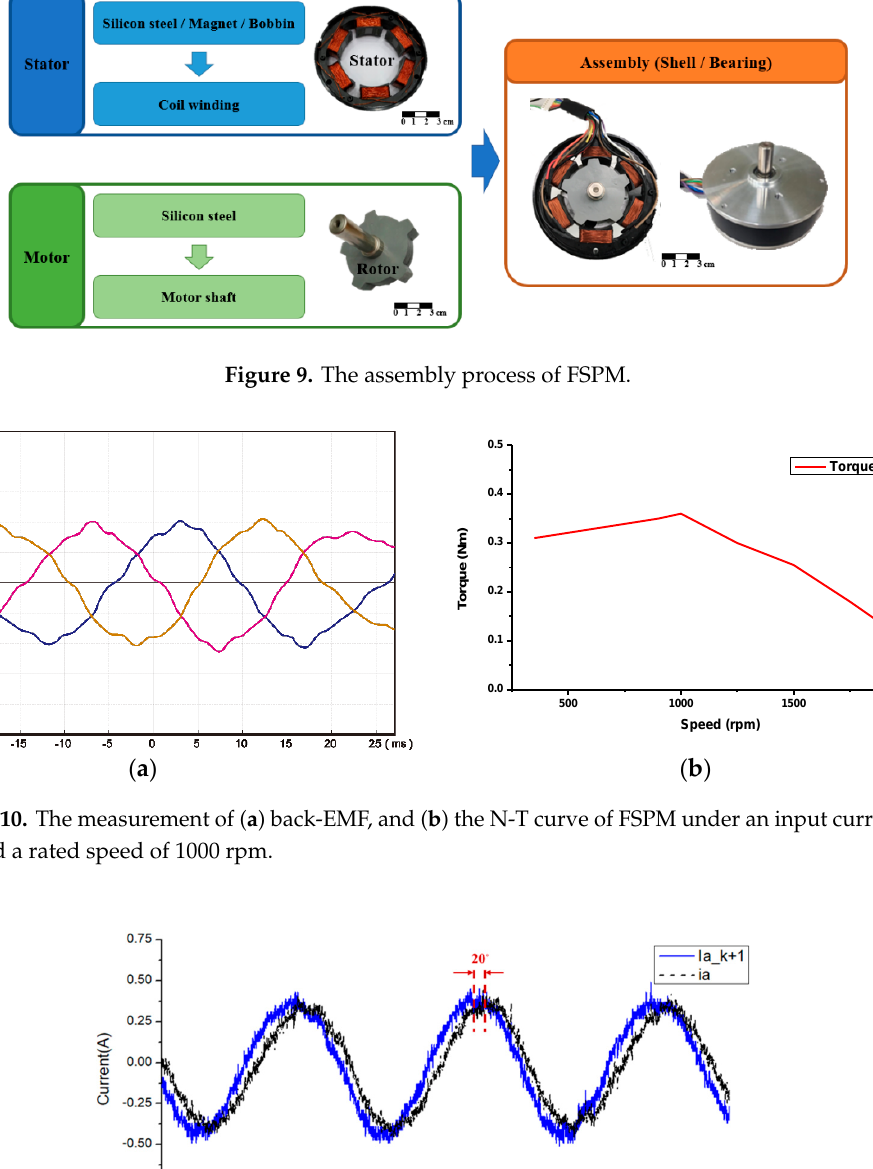
( a ) ( b ) Figure 12. The step response for no load at a speed of 350 rpm: ( a ) the traditional PI control, and ( b ) the proposed modified MPCC. Figure 13 shows the steady ‐ state performance of the two methods with 0.2 Nm load at 1000 rpm. From the top to bottom, the curves are rotor speed, electromagnetic torque, and one ‐ phase stator current. The ripple of the torque and speed of the two methods are also very similar at rated speed. However, when the speed drops to 350 rpm, the difference between the two methods begin to differ significantly, as shown in Figure 14. It can be found that the proposed modified MPCC had a torque ripple of 5.6%, which has a lower torque ripple than the conventional PI control (10%). According to [26,33], it can be known that excessive torque ripple causes unstable speed and lower efficiency. Therefore, it is ideal to maintain the torque ripple below 10% in general. In addition, an external load disturbance was tested to verify that the proposed modified MPCC could achieve better dynamic performance than the traditional PI control. The dynamic test for a disturbance load of 0.2 Nm is shown in Figure 15, at a speed of 350 rpm. When a disturbance of rated half ‐ load was applied to the FSPM, the speed dropped slightly and then ran quickly to its original reference speed. It can be found that the proposed modified MPCC had a better dynamic performance than the traditional PI control, and lower torque ripple. Therefore, the proposed modified MPCC effectively improved torque ripple for better steady ‐ state performance at the low speed. In the follow ‐ up, the dynamic characteristics of the FSPM at the low speed are discussed in detail. The execution times in both implementations are shown below. The execution times of the traditional method and the improved MPCC method were 78 μ s and 32 μ s, respectively, as shown in Figure 16. The results show the improved MPCC method with shorter execution time. The MCU was able to get more working bandwidth.